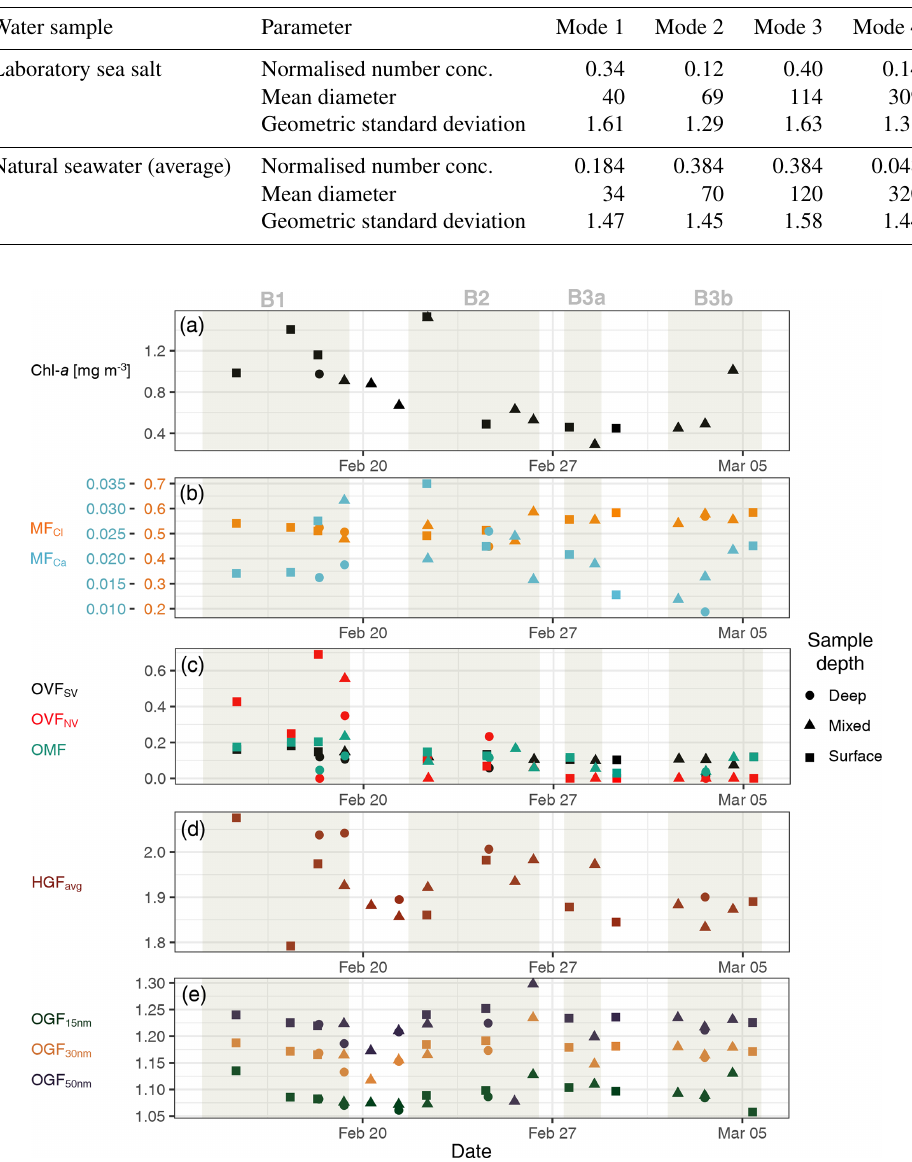
Table 1. Nascent SSA log-normal parameters.